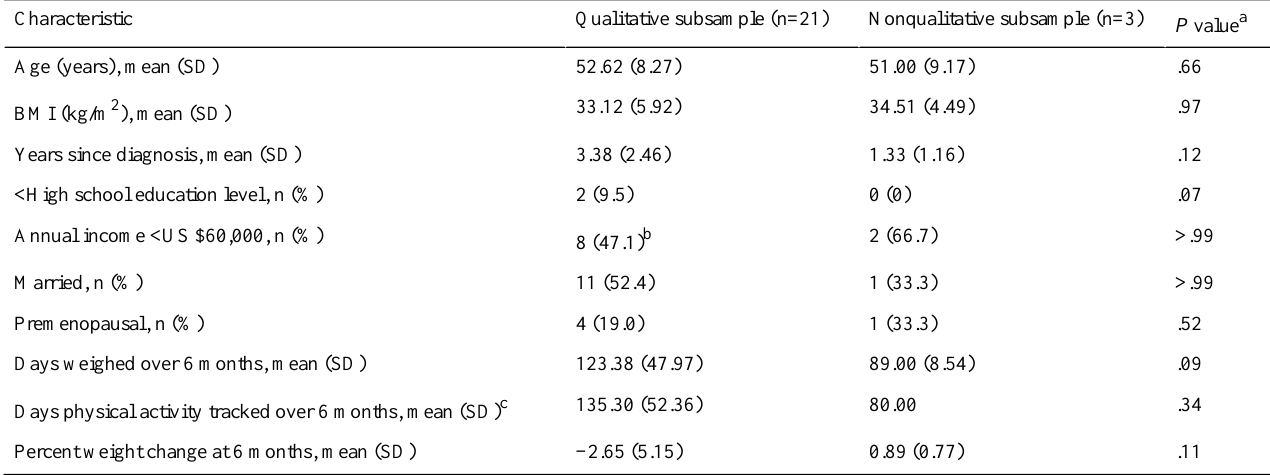
Table 2. Characteristics of intervention participants in WELL body